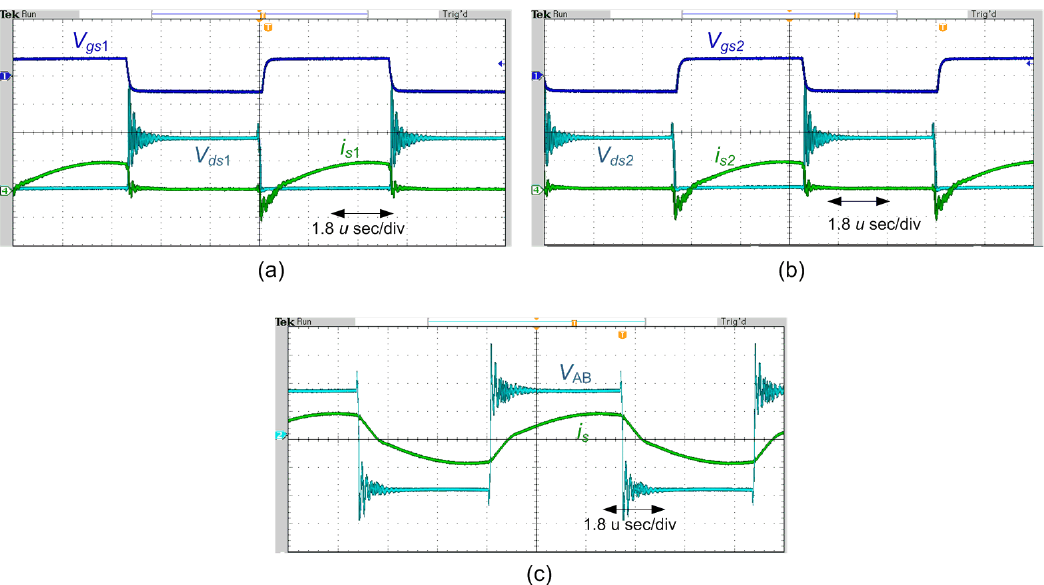
Figure 8. Experimental waveforms at V 1 = 42 V, V 2 = 48 V for 250 Watt load ( a ) V gs 1 (25 V/div), V ds 1 : (50 V/div), i S 1 : (10 Amp/ div); ( b ) V gs 2 (25 V/div), V ds 2 : (50 V/div), i S 2 : (10 Amp/ div); ( c ) V AB : voltage across inverter (25 V/div), i s : resonant current (10 Amp/div).